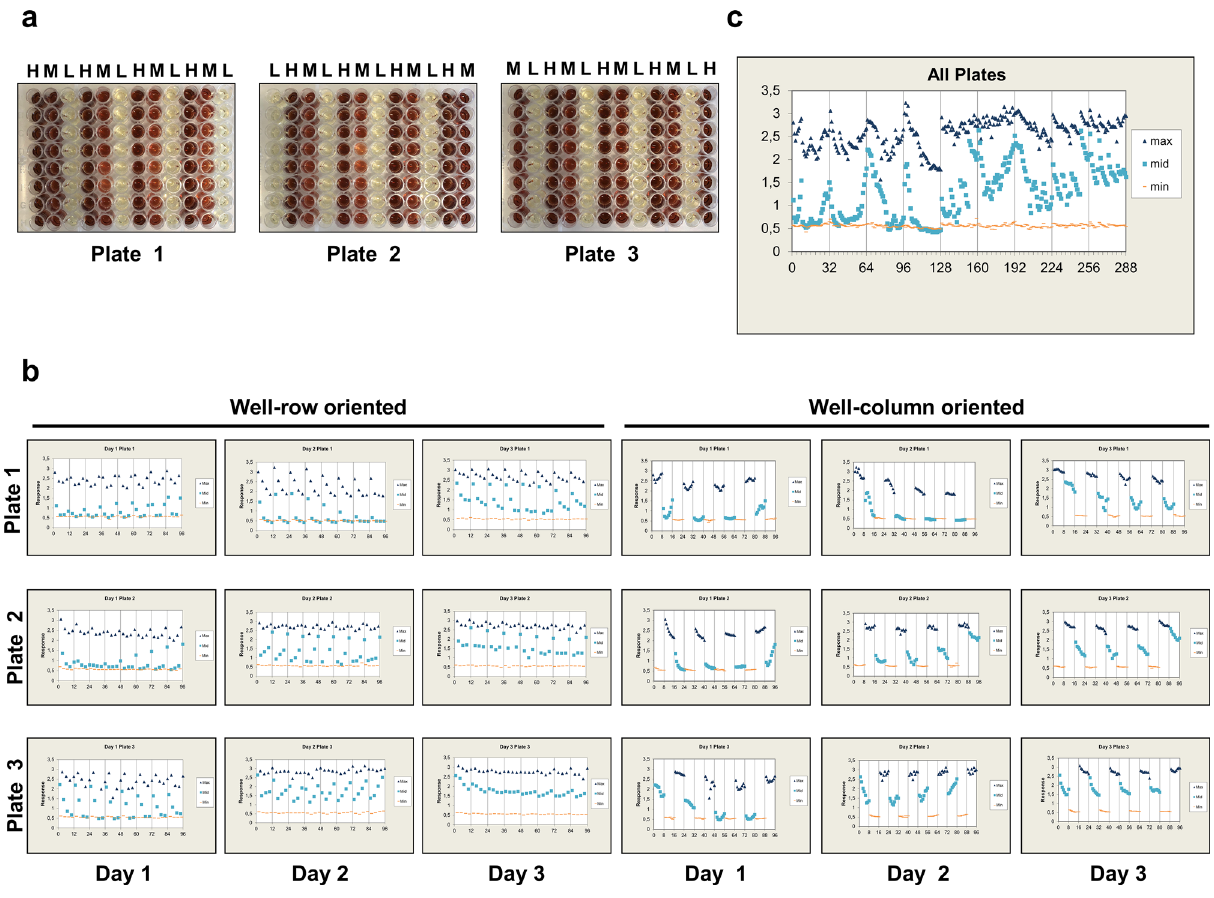
Figure 5. ( a ) To assess the plate uniformity and separation of the signals in our HTS assay at an expression temperature 22 °C; a plate uniformity test was conducted at maximum, medium and minimum signals—0%, 37% and 100% residual HGD activity—in an interleaved signal format to guarantee that the SW is capable of ranking HGD missense variants during screening. All three signals were distributed on each plate but varied systematically so that on all plates, on a given day, each signal is measured on each plate to detect edge or drift effects (3 plates, 3 days). ( b , c ) The obtained signals were also plotted on a scatter plot to reveal patterns of drift or edge effect or other systemic sources of variability. Signals were plotted against well number, first in a column- wise fashion then in row-wise fashion and significant (> 20%) edge or drift effect were observed indicating that under the applied conditions, no reliable results can be